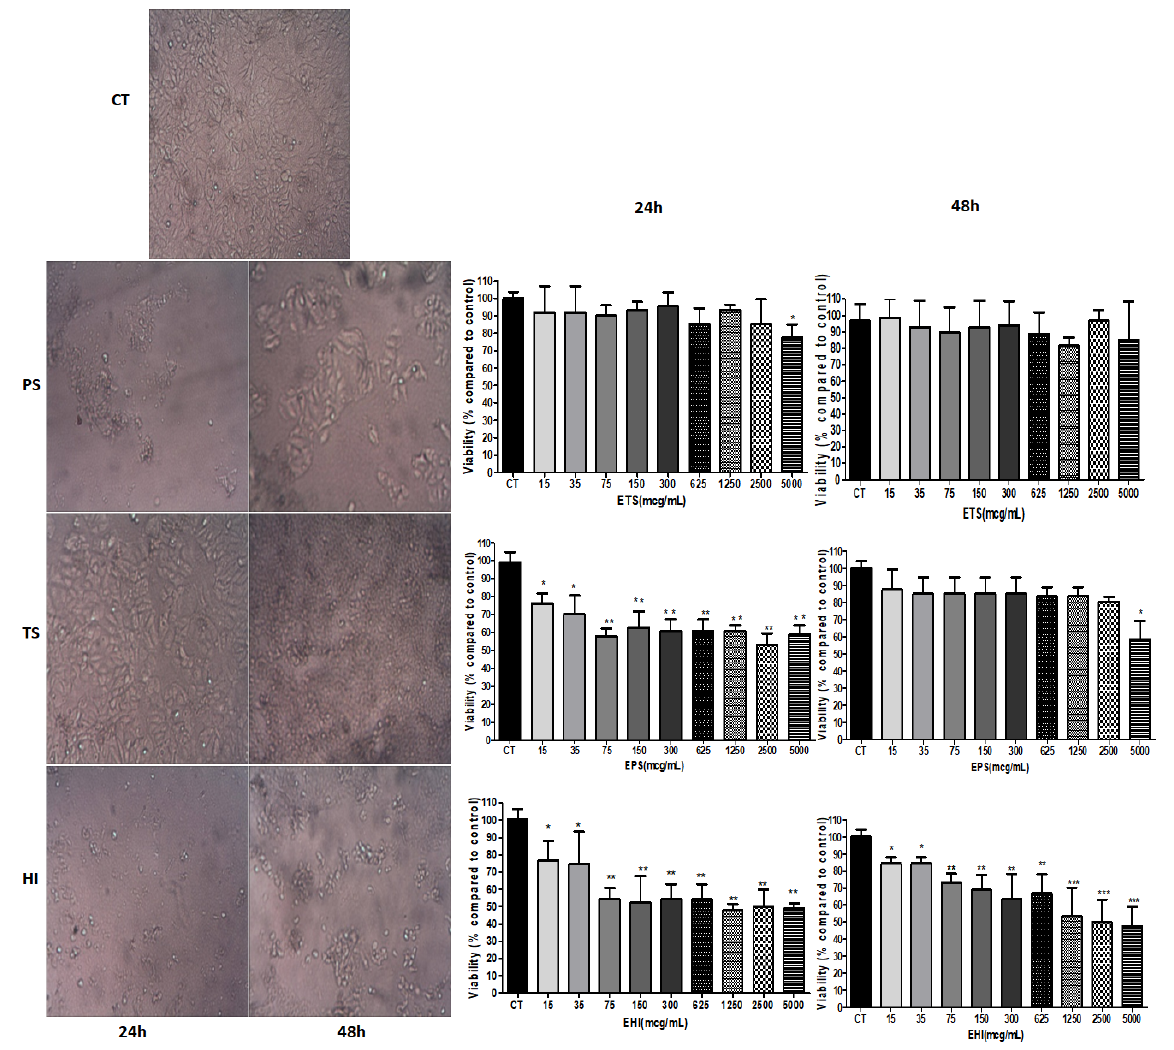
Figure 2. Effect of 24 and 48 hrs incubation of MCF-7 cells with Tsumori (TS), Pedro Sato (PS) and Hitígio (HI) guava cultivar extracts (15-5000μg /mL) on cells viability. Results were compared by One- way ANOVA followed by Tukey test Significant differences are indicated as * p<0.05 and ** p